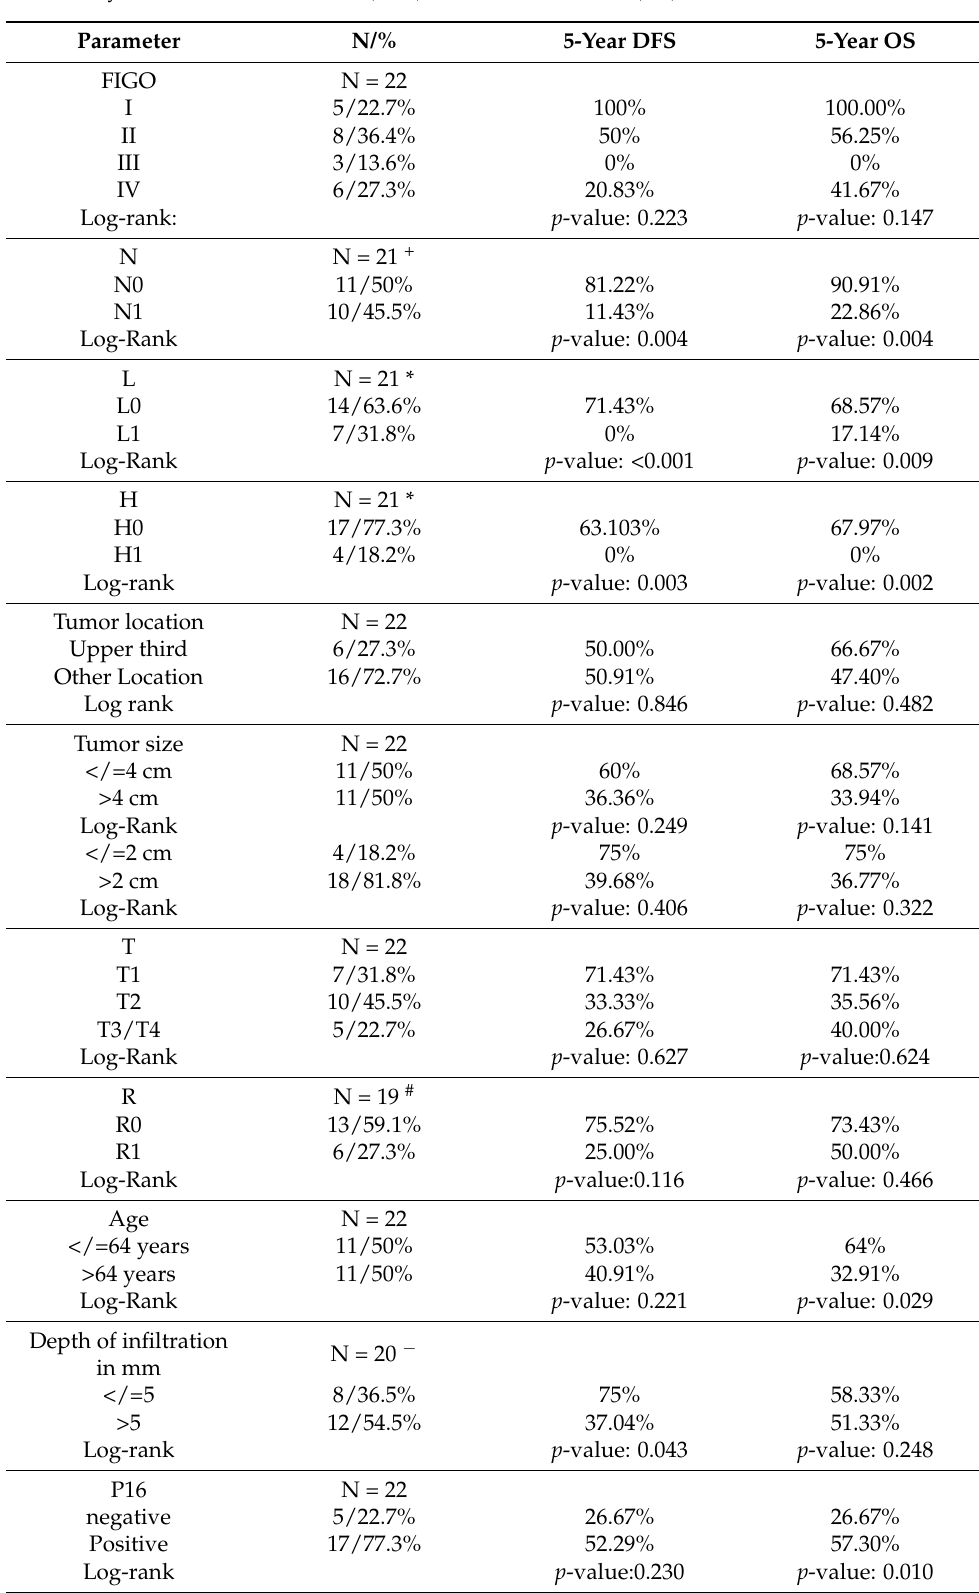
Table 2. 5 year-disease-free survival (DFS) and overall survival